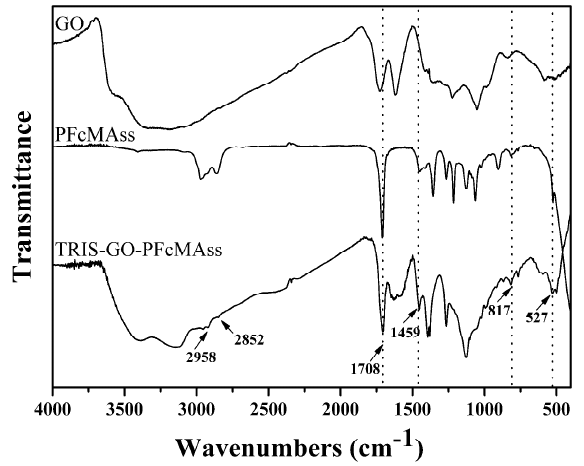
Figure 3. FT-IR spectra of GO, PFcMAss and GO-PFcMAss.